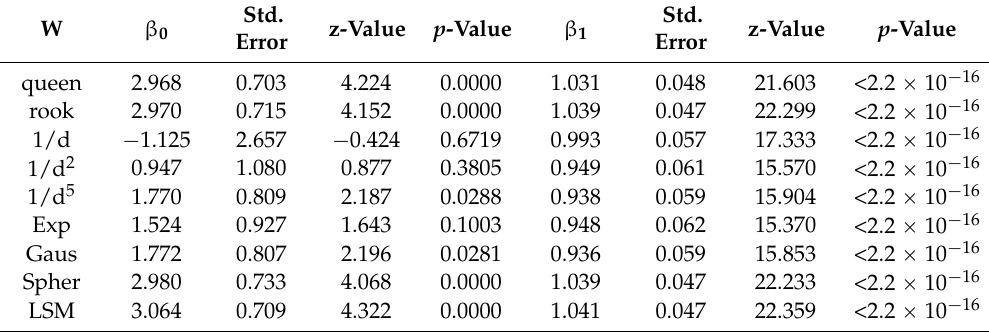
Table 4. Model coefficient estimates of SLM for nine spatial weight matrices.